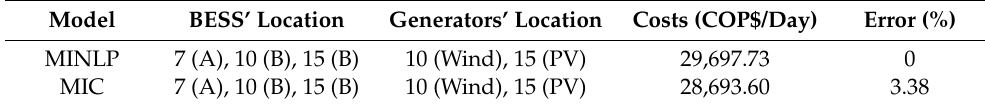
Table 8. Numerical results for the MIC and MINLP models in Case 3. Model BESS’ Location Generators’